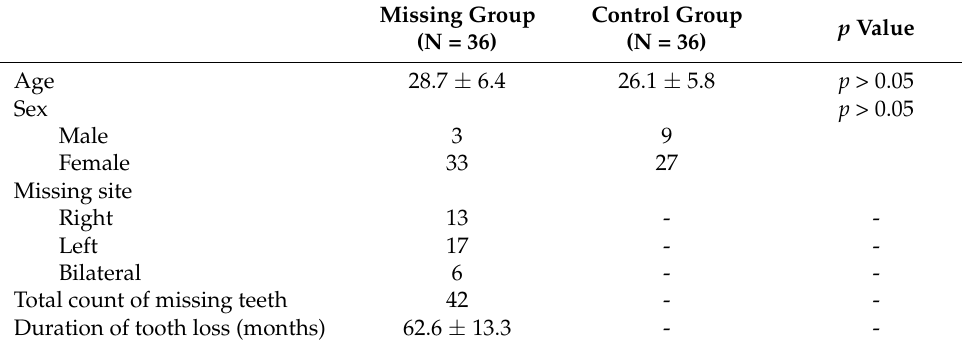
Table 1. Patient